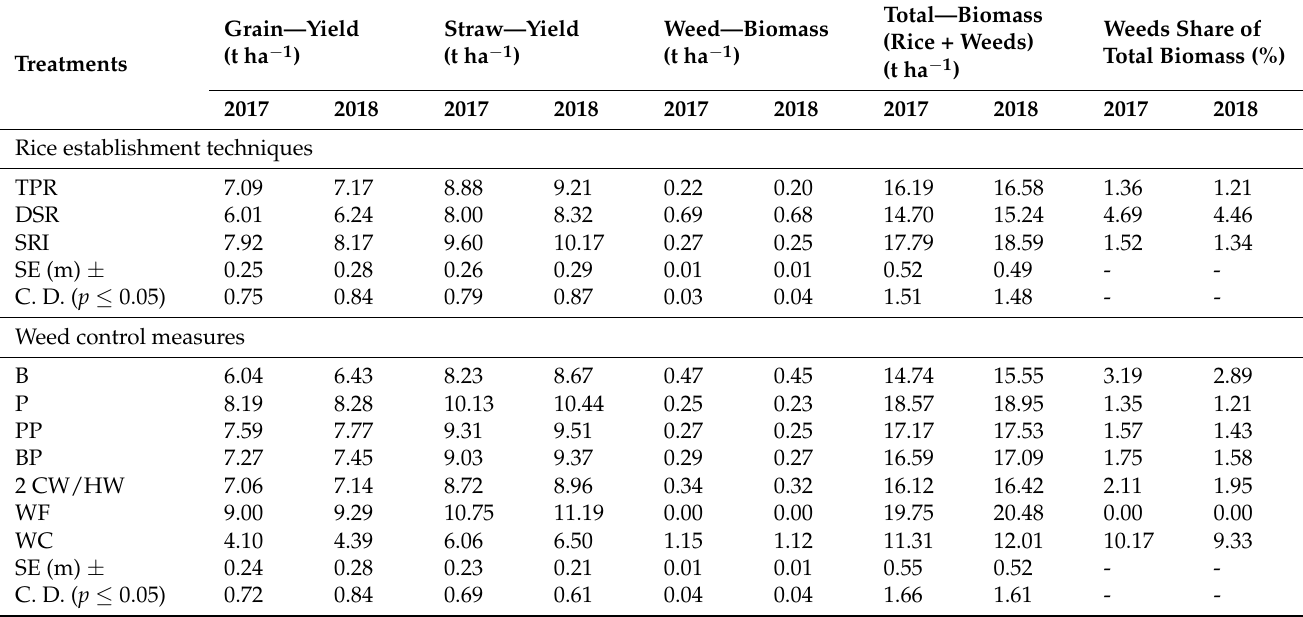
Table 3. Yield (t ha − 1 ) of rice, weed biomass (t ha − 1 ) and biomass share of weeds as influenced by rice establishment techniques and weed control